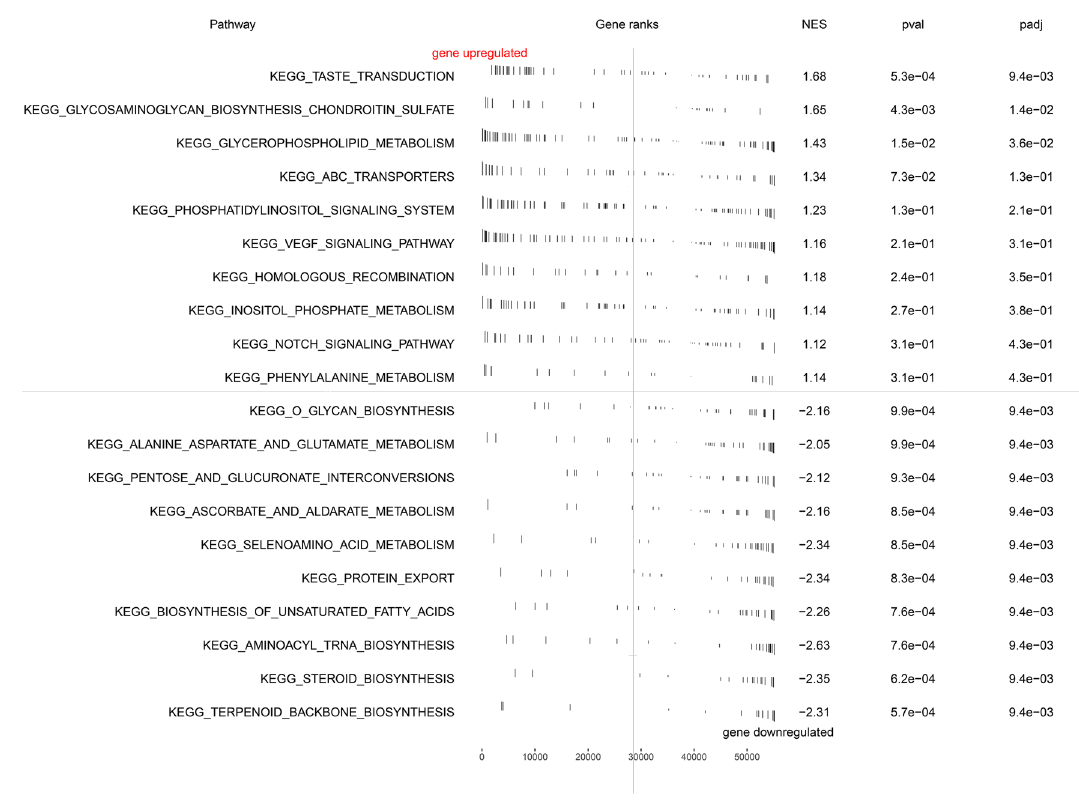
Figure 6. GSEA enrichment